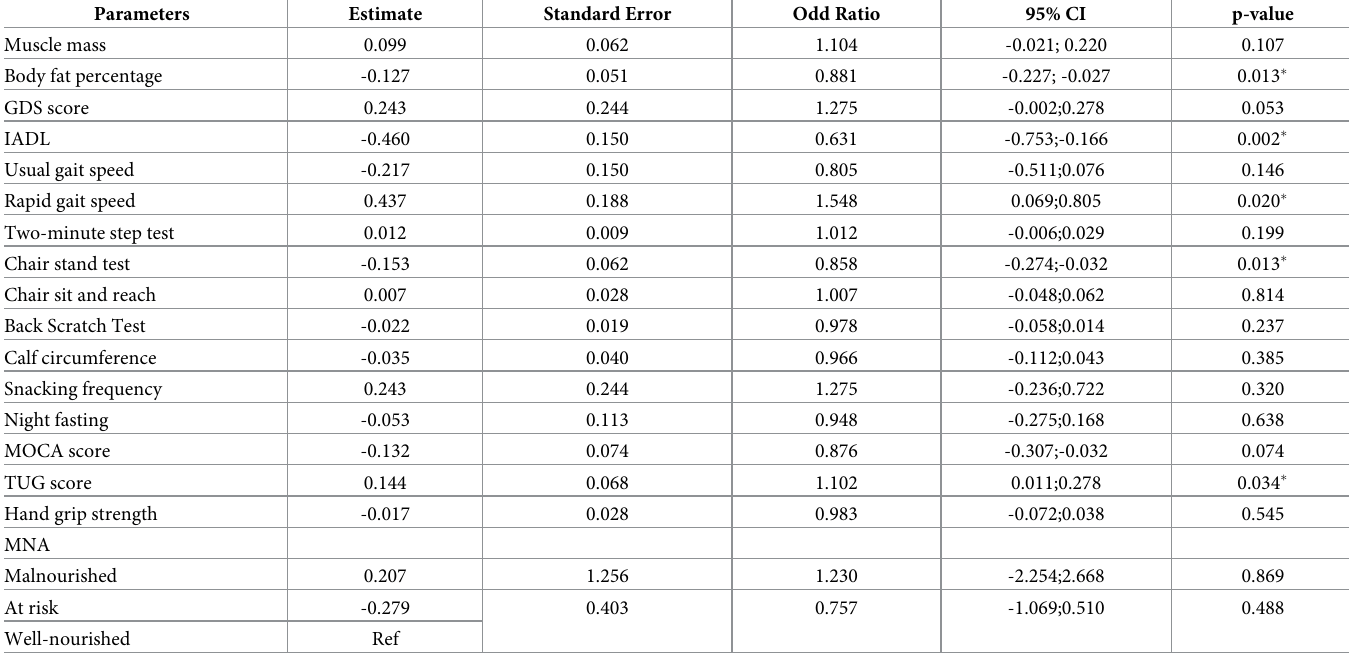
Table 6. Predictors of fear of